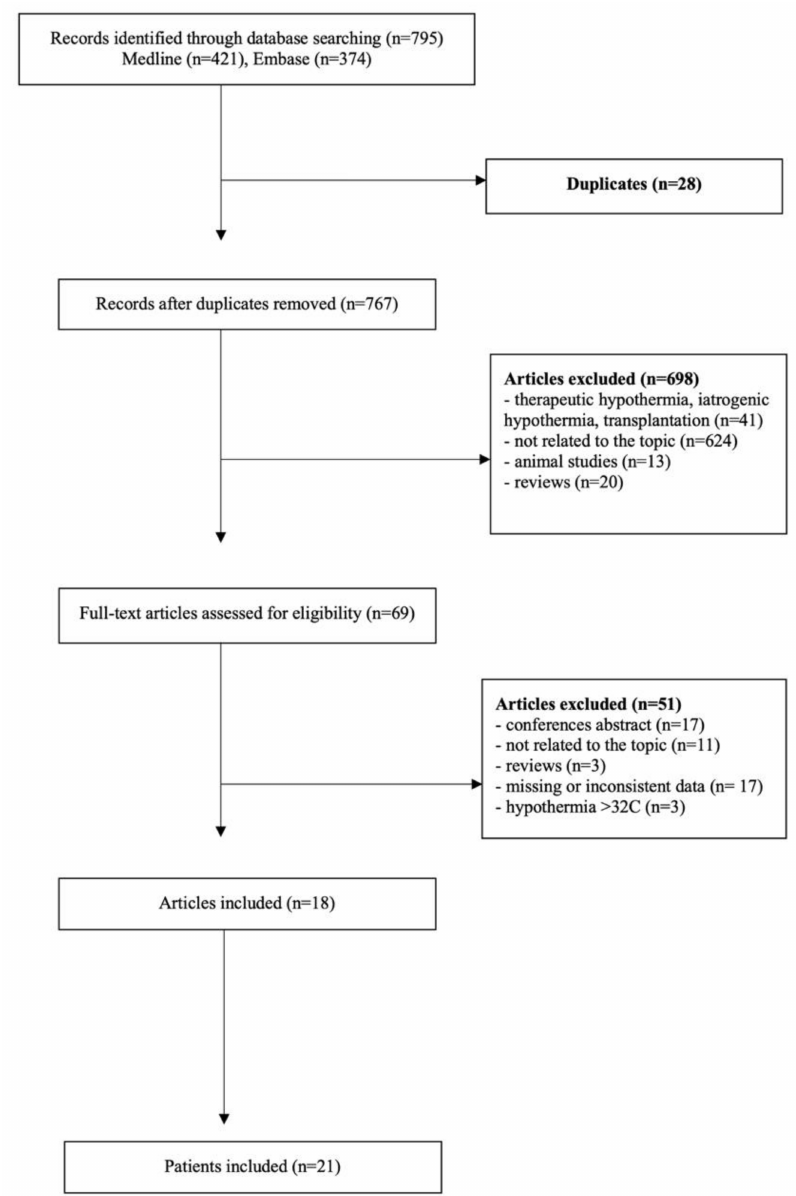
Figure 1. PRISMA